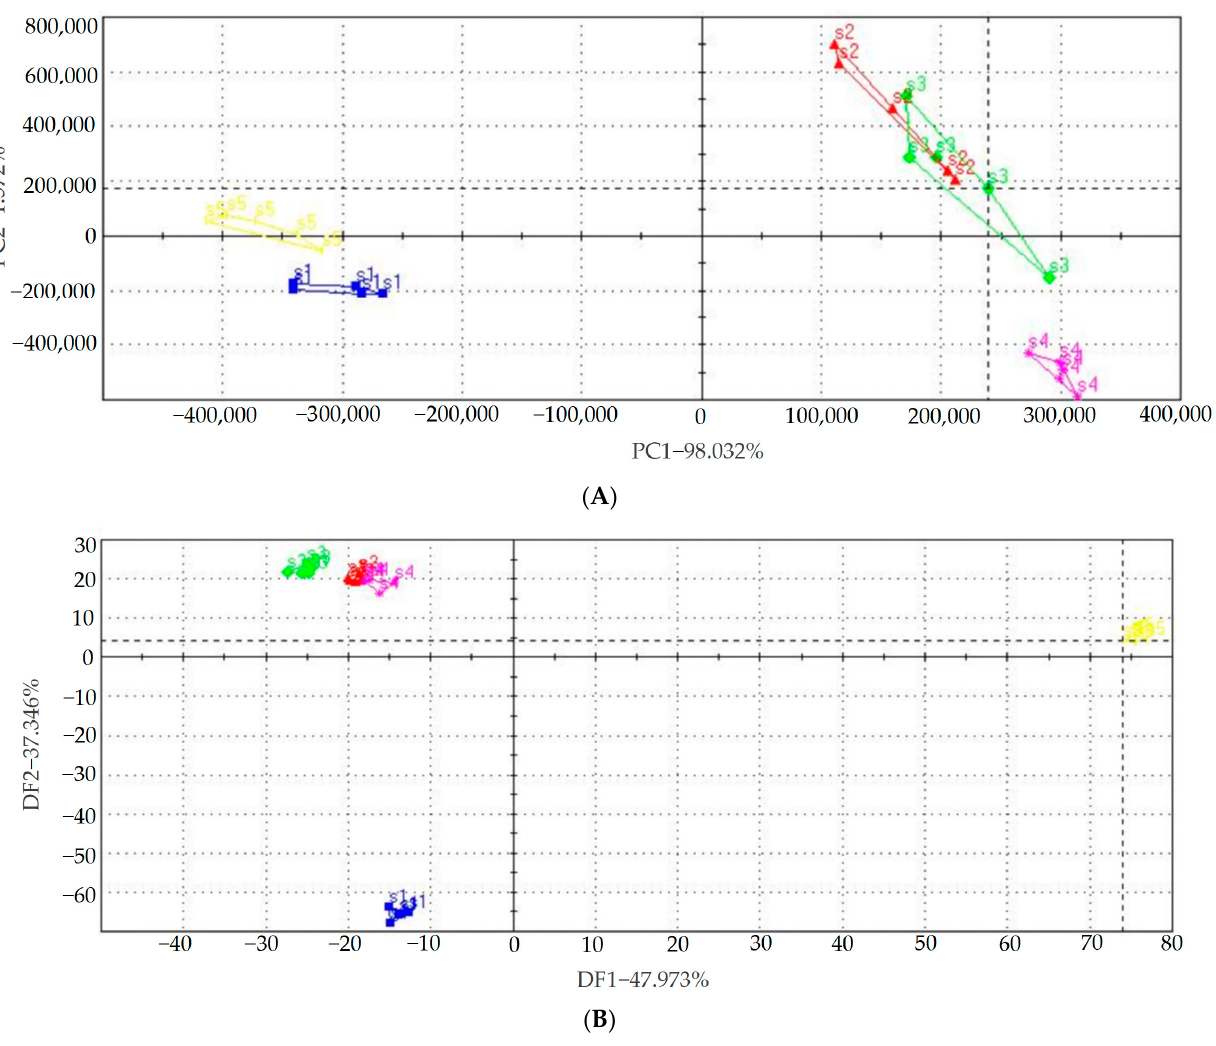
Figure 3. E-nose analysis results of di ff erent brown rice products ( n = 5). ( A ) PCA score plot. ( B ) DFA score plot. Where S1: WR, S2: BR, S3: GBR, S4: FBR, S5: EBR (WR—white rice, BR—brown rice, GBR—germinated brown rice, FBR—fermented brown rice, EBR—extruded brown rice).